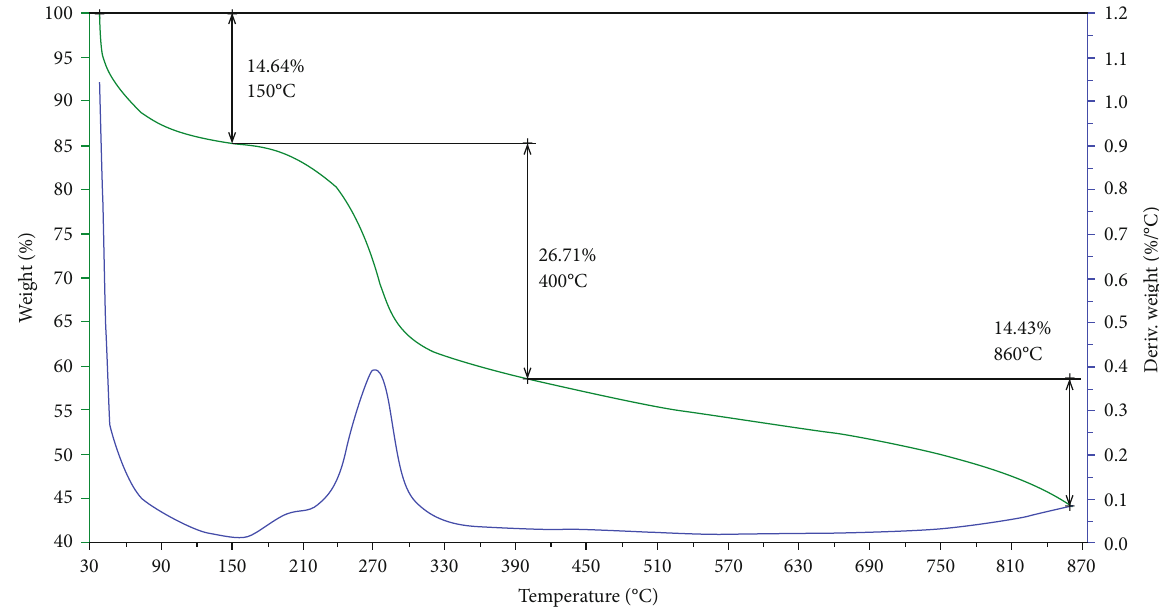
Figure 11: Weight vs. temperature for SA-Ag-NP-incorporated chitosan